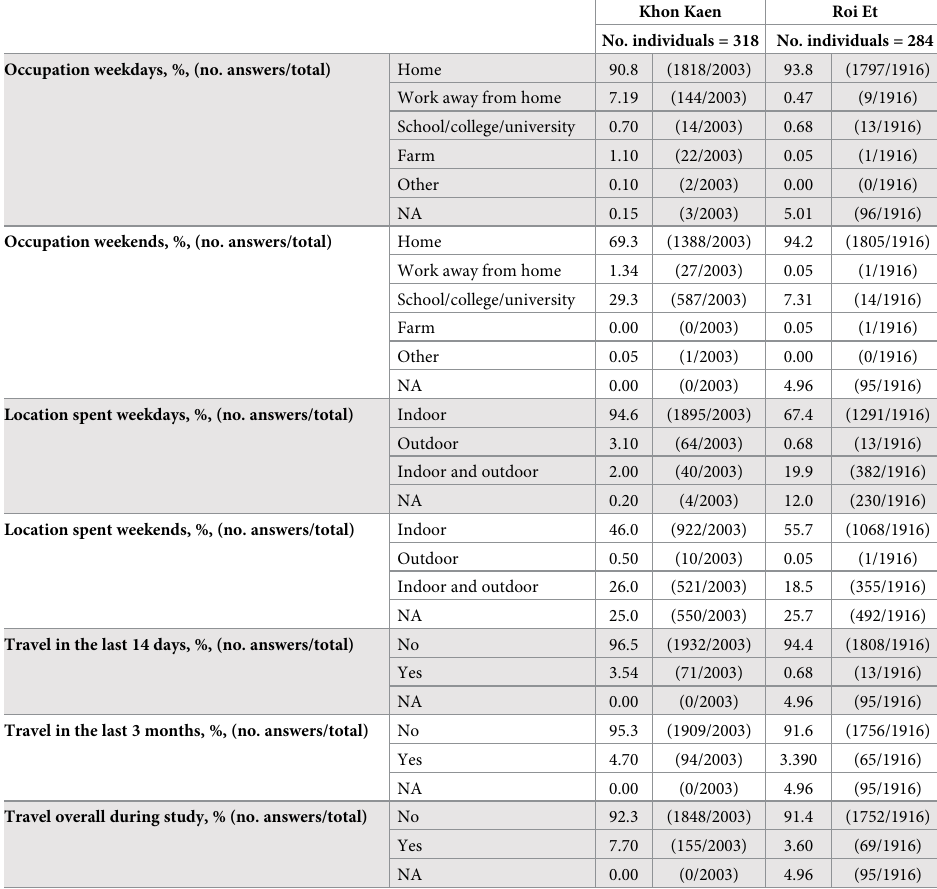
Khon Kaen Roi Et No. individuals = 318 No. individuals = 284